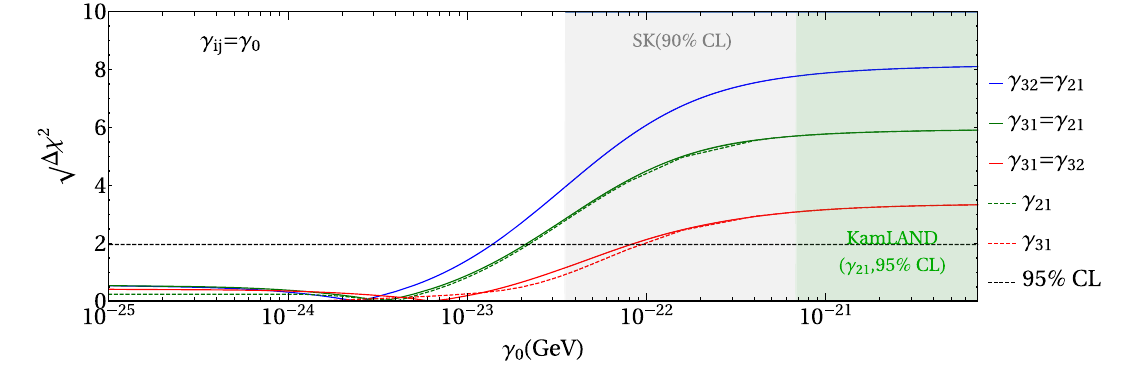
(cid:14) Δχ 2 for the Atmospheric (solid red curve), Solar I (solid green The curve) and Solar II (solid blue curve) limits is also